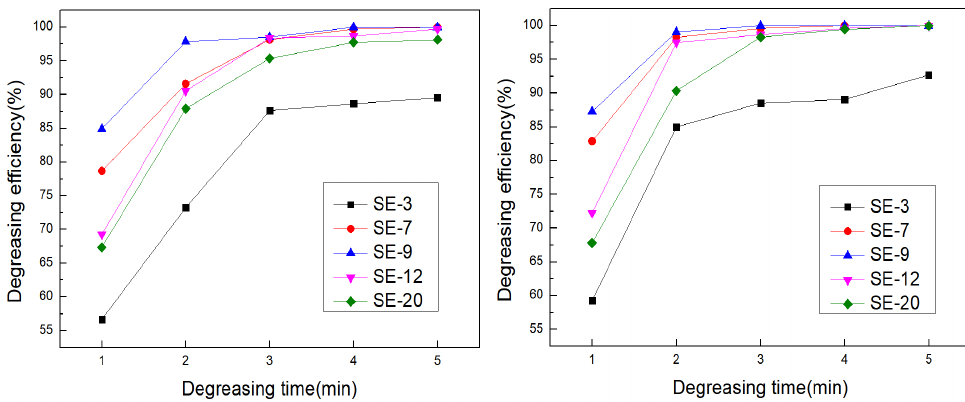
Figure 1. Degreasing efficiency over time with the various degreasing solutions at 30 °C ( left ) and 40 °C ( right ).